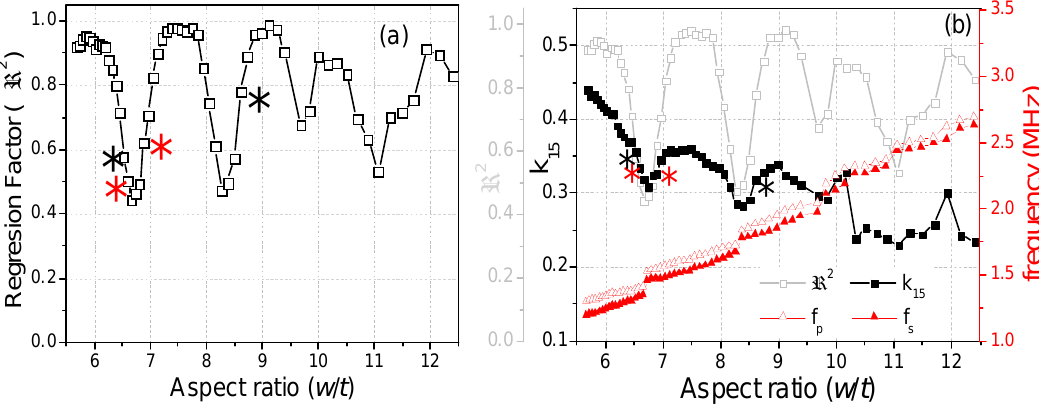
Figure 7. Evolution as a function of the aspect ratio of the BCZT plate: ( a ) of the regression factor, R 2 , reconstructed to the experimental shear resonance spectra (the points marked with (*) correspond to the spectra of Figures 4 and 6, which are examples of coupled modes with low (black) and very low (red) R 2 , respectively) and ( b ) of the frequencies fp and fs and the electromechanical coupling factor, k 15 ; all parameters of coupled modes were recalculated by the modified automatic iterative